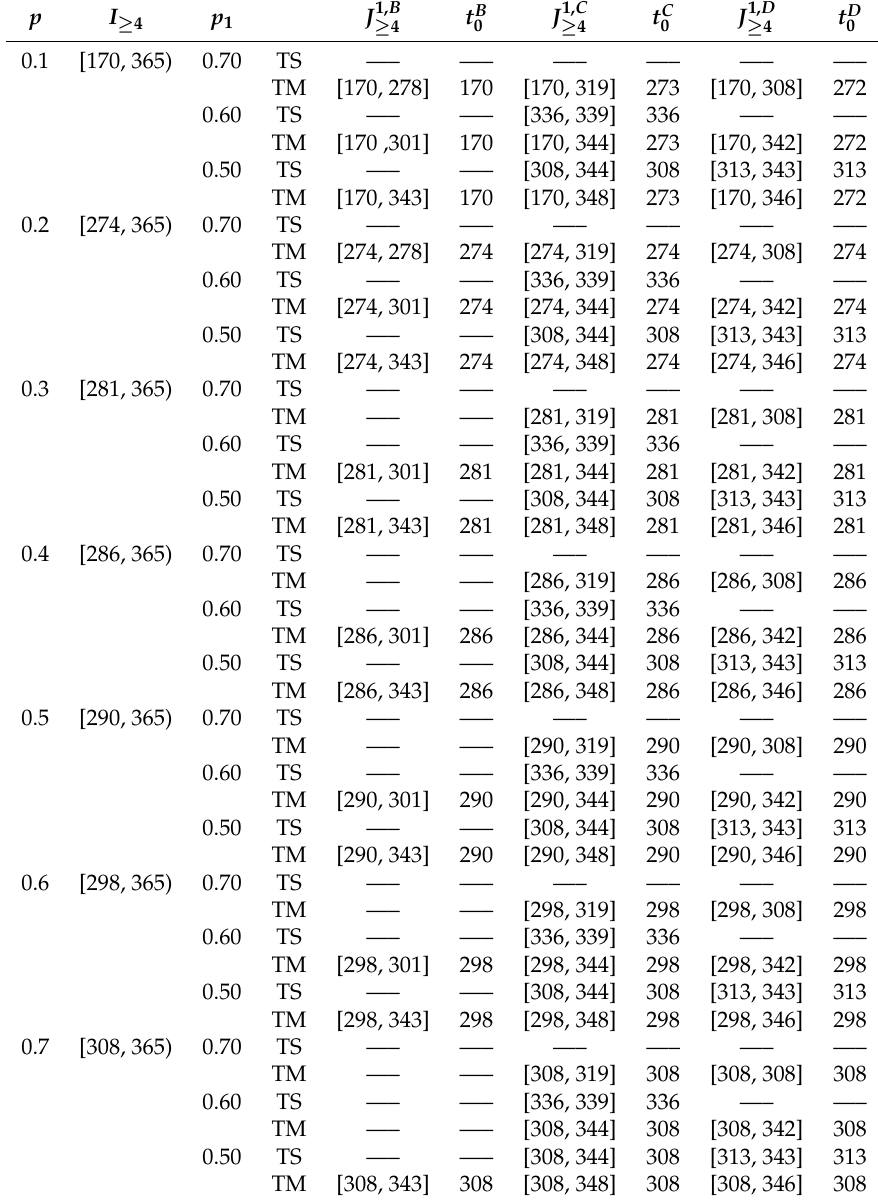
Table A2. Intervention instants t 0 versus the index p and the lower bound p 1 for effectiveness (Criterion 1) for m (cid:48) = 4. Grazing strategies TS and TM with the anthelmintics ivermectin (B), fenbendazole (C) and albendazole